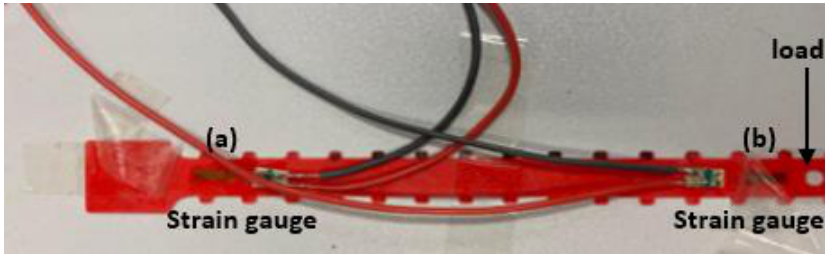
Figure 7. Plane view of strain gauge mounting points on test beam ( a ) fixed support and ( b )